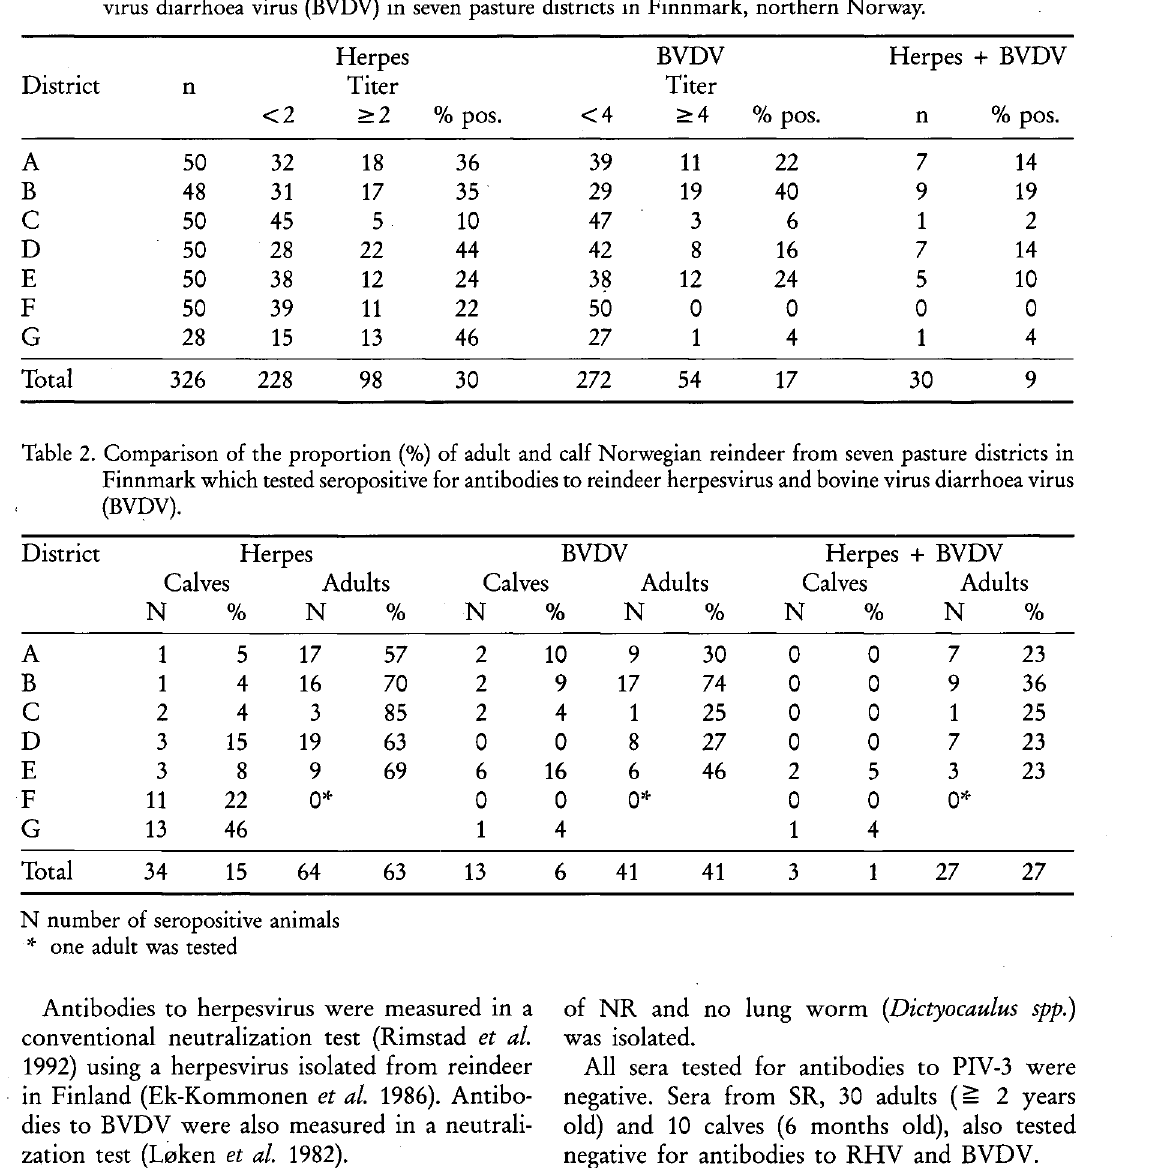
Table 1. Proportion (%) of seropositive Norwegian reindeer tested for antibodies to reindeer herpesvirus and bovine virus diarrhoea virus (BVDV) in seven pasture districts in Finnmark, northern Norway. Herpes B V DV Herpes + B V DV